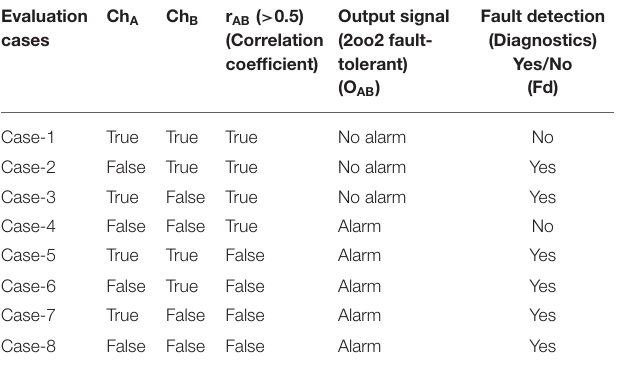
TABLE 1 | 2oo2-based safe-voting logical truth table for fault detection using a correlative technique. Evaluation